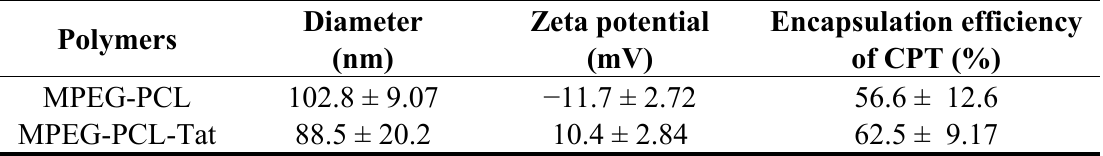
Table 2. Particle diameter, zeta potential and encapsulation efficiency of camptothecin (CPT)-loaded MPEG-PCL and